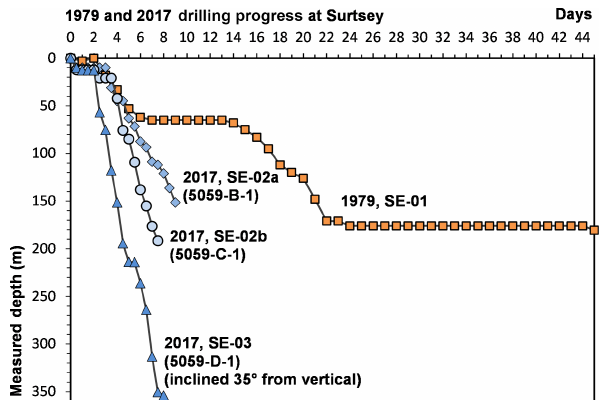
Figure 6. Rates of drilling progress in 1979 and 2017 (following Weisenberger et al.,